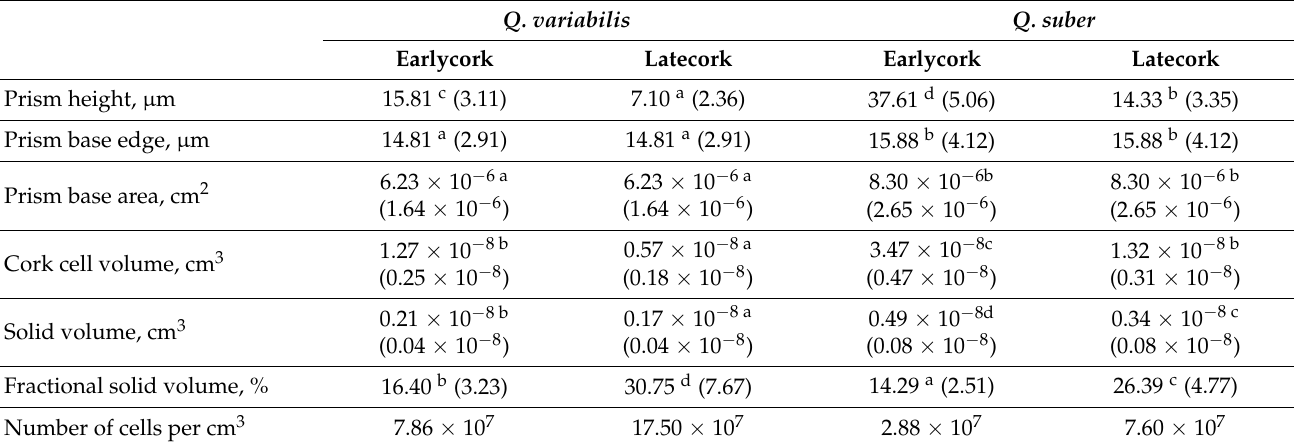
Table 7. Three-dimensional characteristics of the cork cells in Q. variabilis virgin cork and Q. suber reproduction